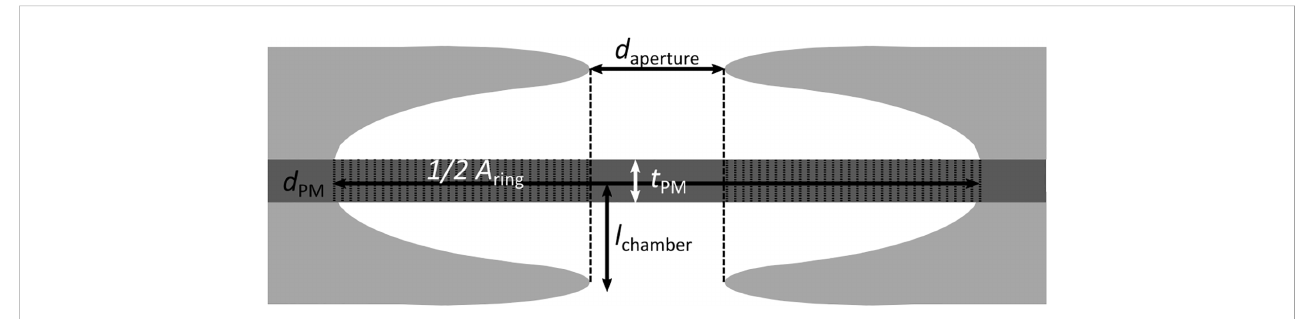
FIGURE 1 Anatomical parameters measured in pit membranes, visualized in a median transverse section through a single pit. d aperture : Diameter of the aperture, measured in SEM pictures. d PM : diameter of the pit membrane, measured in AFM and SEM pictures. A ring : Area of the pit membrane not covered by the projection of the aperture, calculated based on d aperture and d PM . t PM : thickness of the central pit membrane, measured in TEM pictures. l chamber : chamber depth, measured in TEM